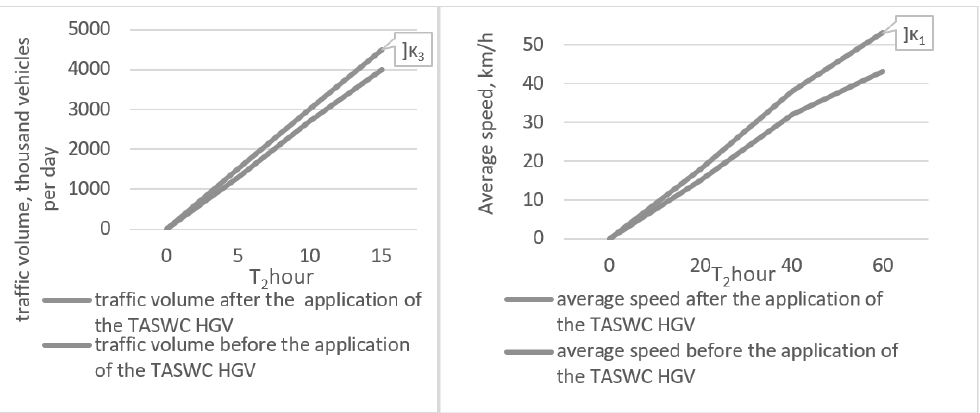
Figure 8. Effect of TASWC HGV on the performance of the road.